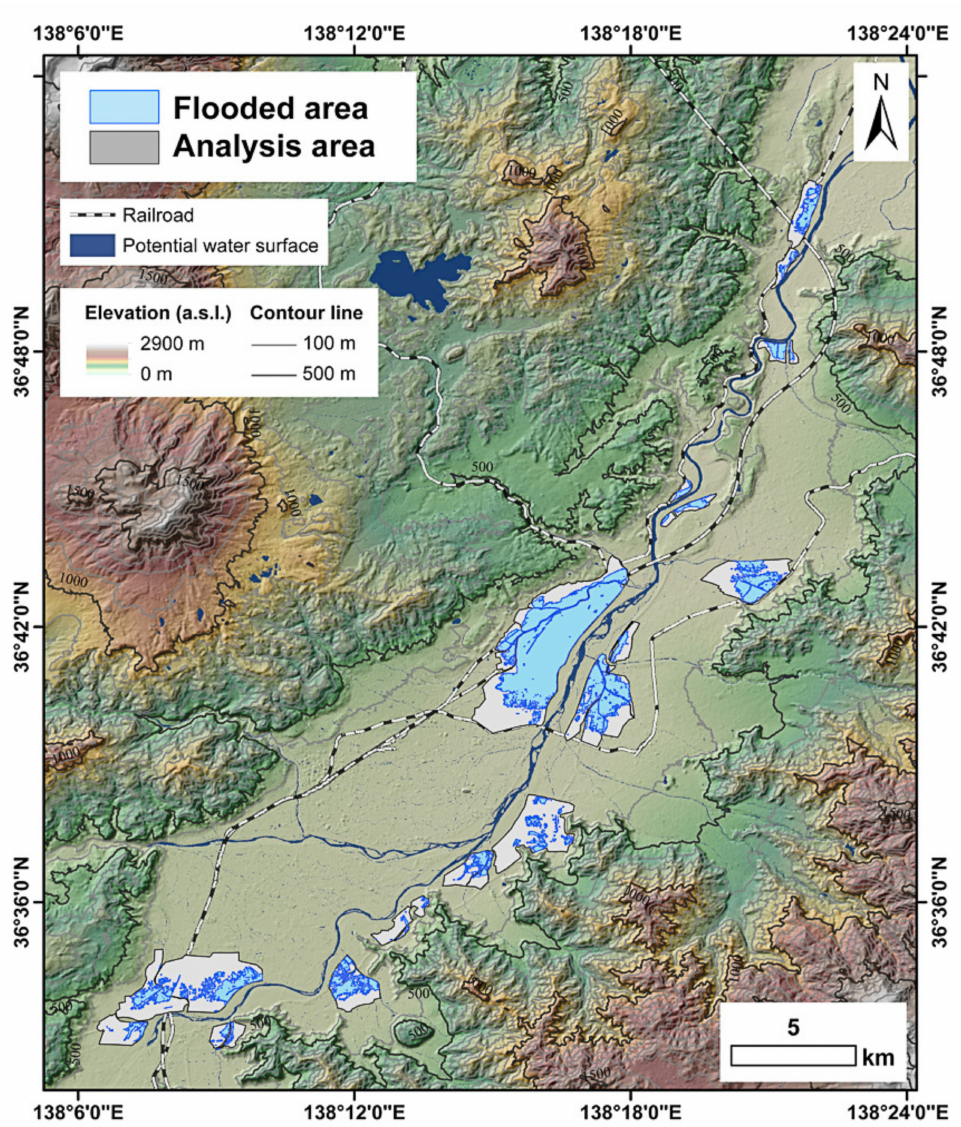
Figure 1. Spatial distribution of the analysis area and flooded regions. The background topography from ALOS World 3D-30 m provided by © JAXA and the cartography by GSI are